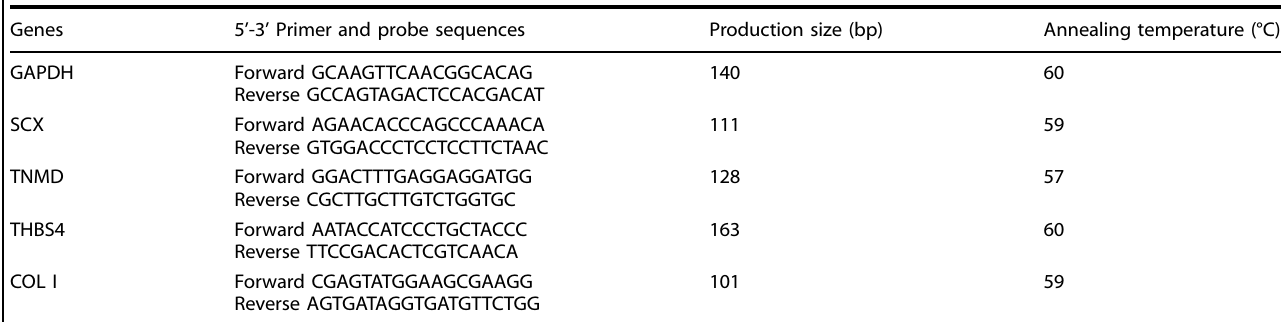
Table 1. Primer sequences, product size and annealing temperature used for PCR